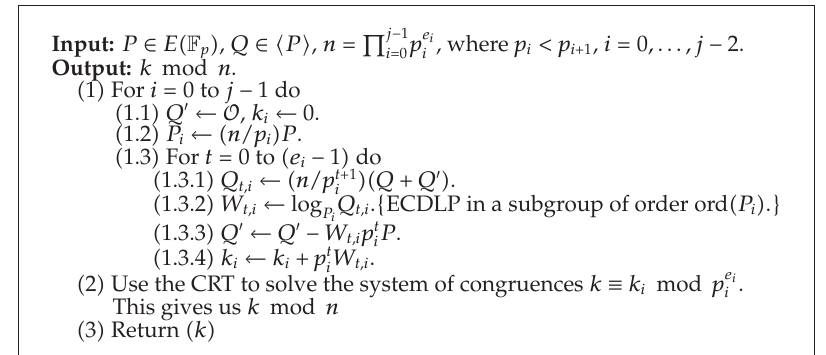
Algorithm 1: Silver-Pohlig-Hellman algorithm for solving the ECDLP.